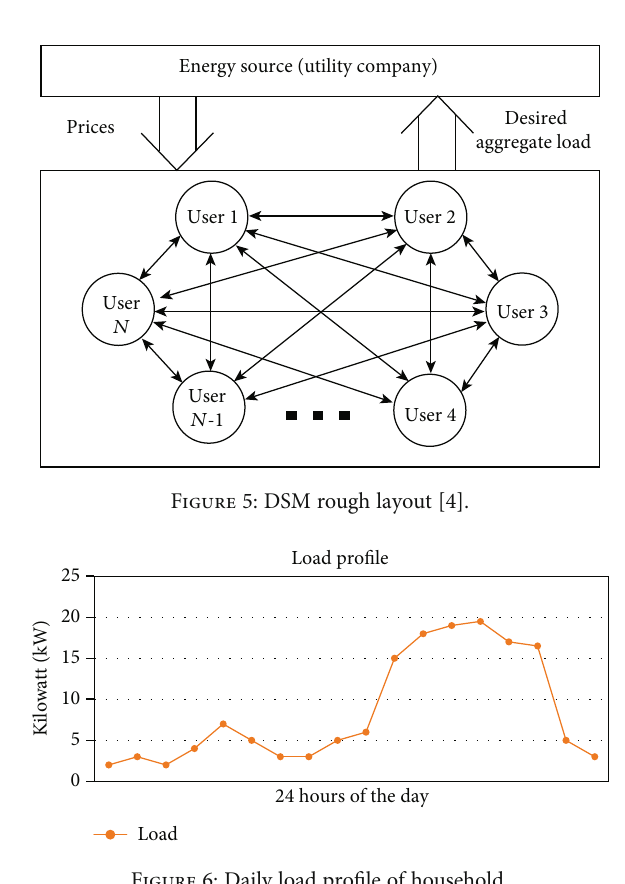
Figure 6. System load pro fi le can be changed by using DSM